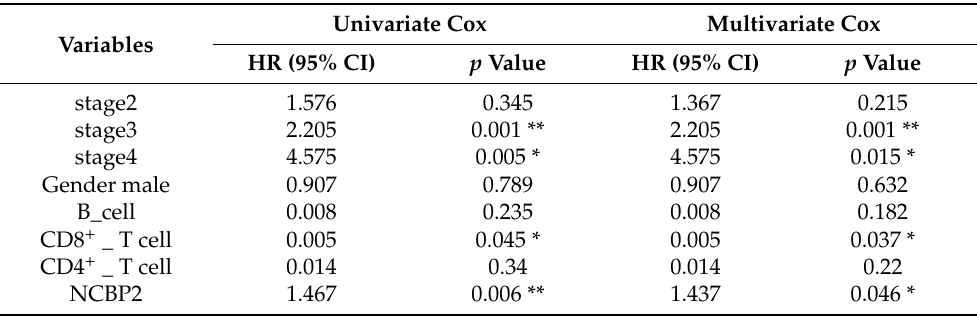
Figure 9. Relationship of NCBP2 expression with immune infiltration level in diverse cancer types Table 1. Univariate and multivariate Cox regressions on clinicopathological characteristics and NCBP2 expression